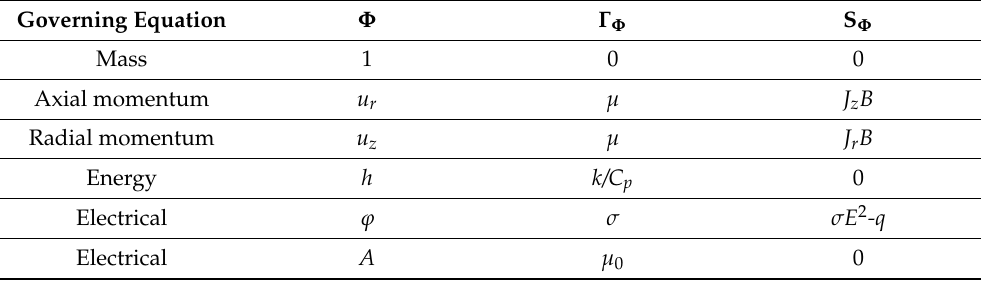
Table 1. The governing equation parameters and source